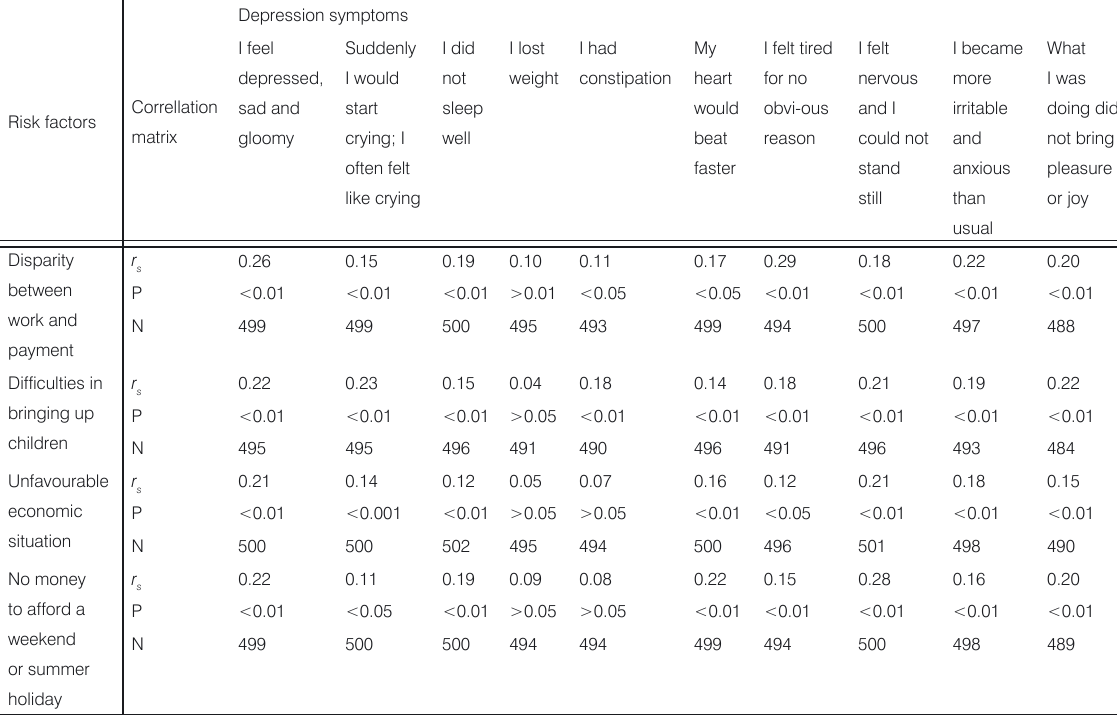
Table 2. Correlation between socio-economic factors and depression